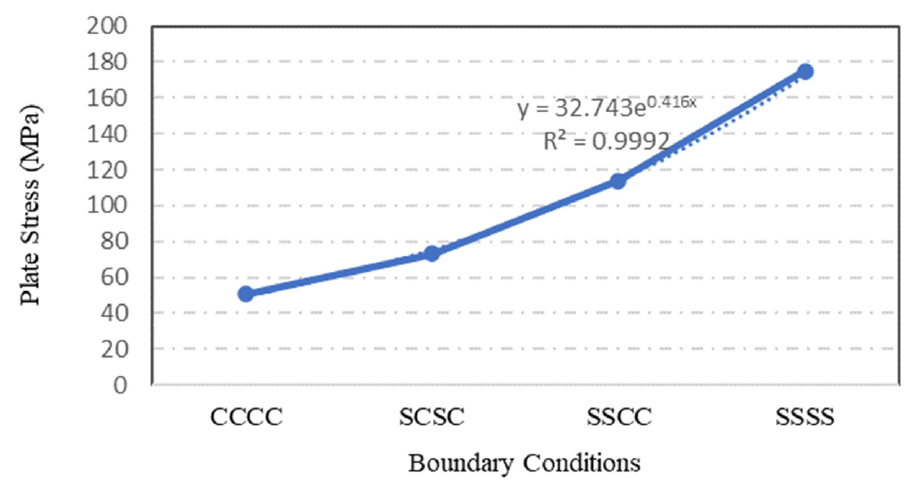
Figure 24. Variation in plate maximum stress with different boundary conditions. The type of boundary condition applied to the plate specimen’s edges determined the degree of freedom at the edge of steel plate. From the ANSYS simulation of the four S-3 plates with different boundary conditions, it was found that the plate specimen with